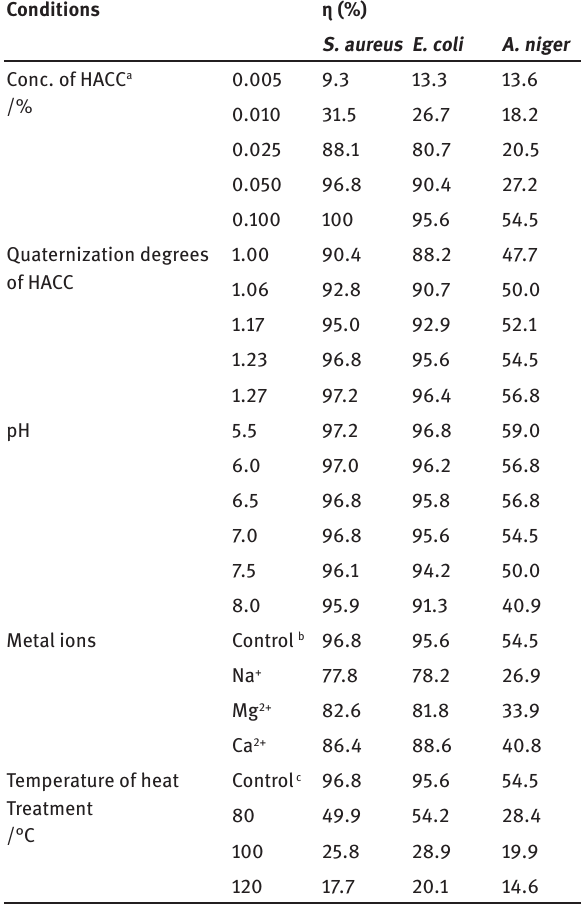
Table 1: Effect of factors on antimicrobial activities. Conditions